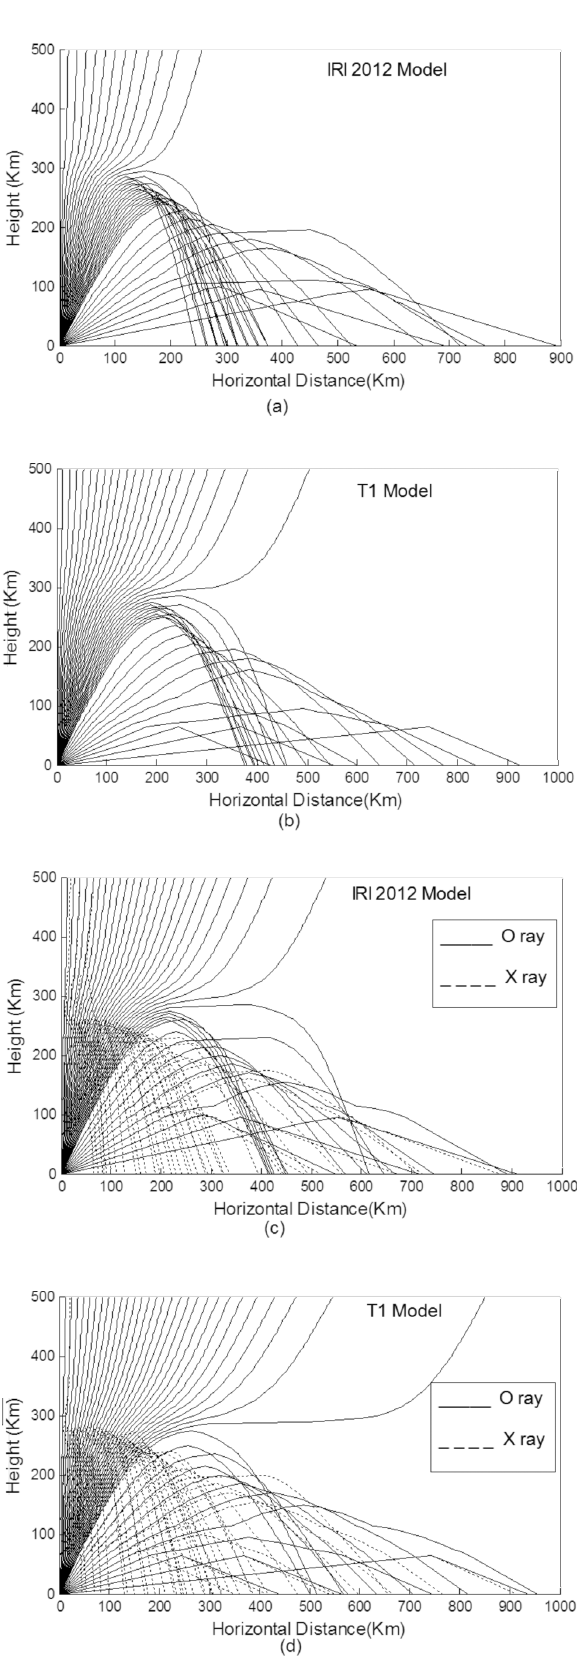
Figure 5. Ray tracing for different angle of incidence at 7.5 MHz under Case 2 for: (a) IRI 2012 model of the ionosphere without in- fluence of magnetic field, (b) T1 model of the ionosphere without influence of magnetic field, (c) IRI 2012 model of the ionosphere under influence of magnetic field, (d) T1 model of the ionosphere under influence of magnetic